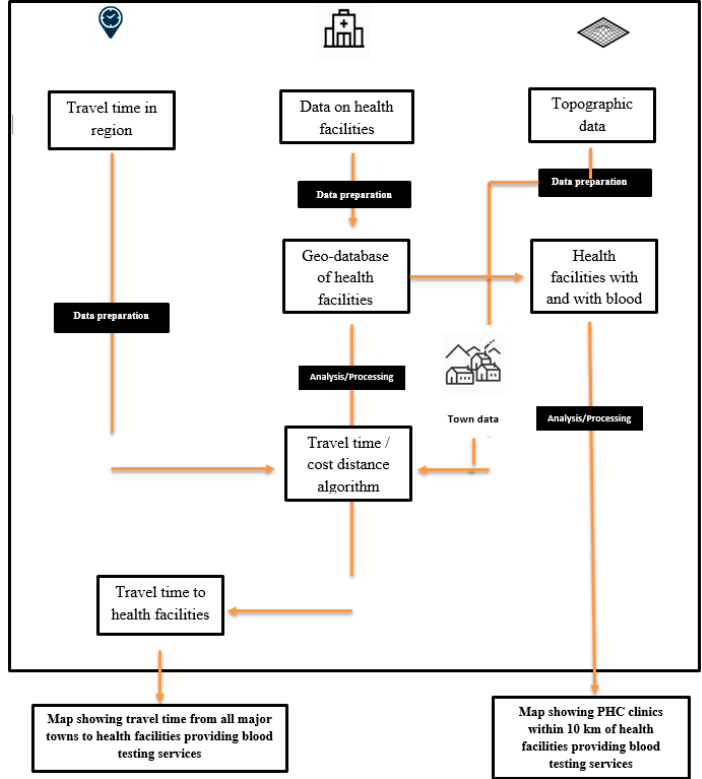
Figure 1. A flow diagram illustrating the data, methods, and models used. PHC—primary healthcare.